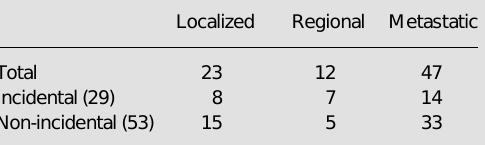
Table 1 - Staging of 82 cases of adrenocortical carcinoma.